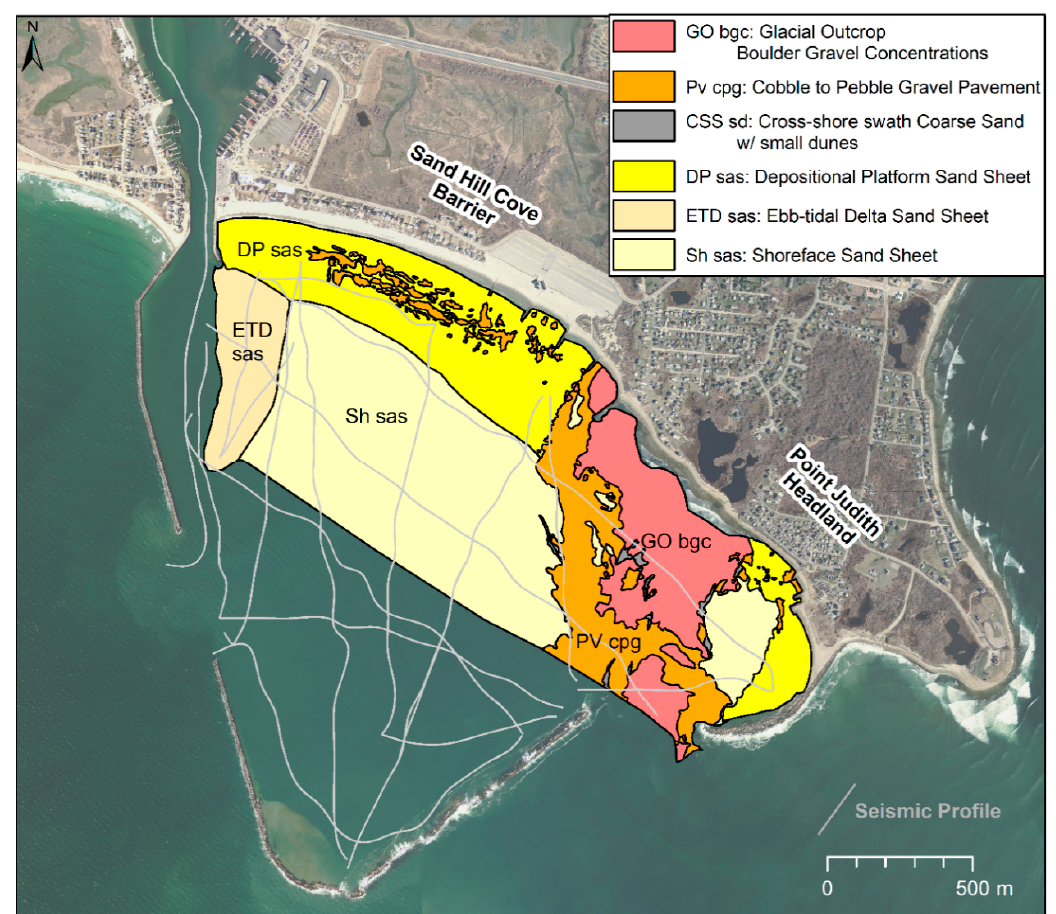
Figure 2. Simplified benthic geologic habitats of the upper shoreface within the HoR. Extent of the units was interpreted from side-scan sonar imagery collected in 2015. See Oakley et al. [14] for detailed descriptions of the shoreface units.